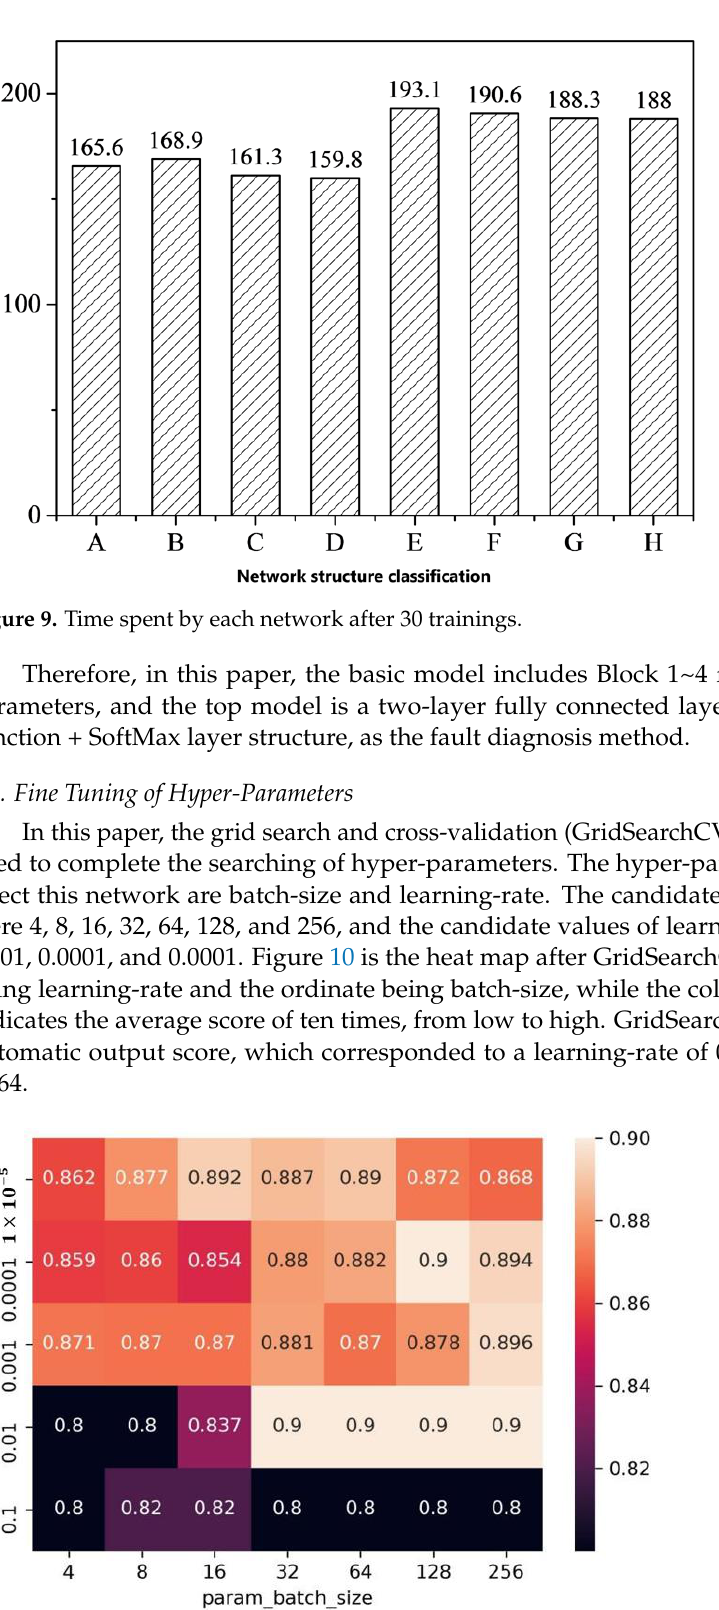
Figure 9. Time spent by each network after 30 trainings.